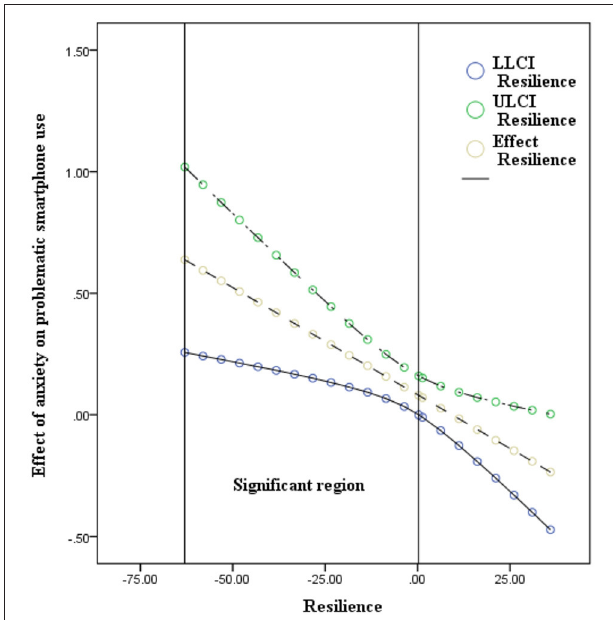
FIGURE 6 | Effects of resilience with 95% confidence interval ( N = 748). LL, low limit, CI, confidence interval, UL, upper limit. The Johnson-Neyman (J-N) method was applied to measure the significant region in which resilience significantly moderated the impact of anxiety on problematic smartphone use. The upper and lower lines indicated the limits of confidence interval and the middle line indicated the effect of resilience. The scores of statistical significance ranged from − 63.027 to